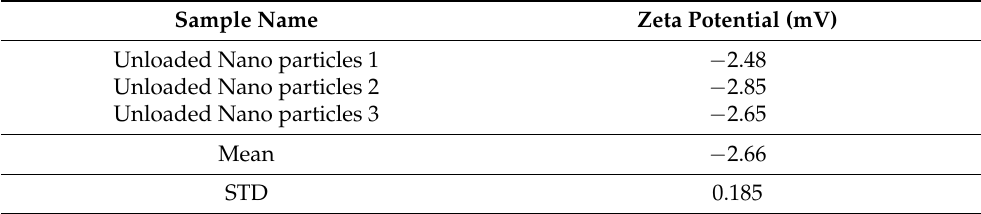
Table 1. Unloaded PLGA-PEG-PLGA NPs surface charge.